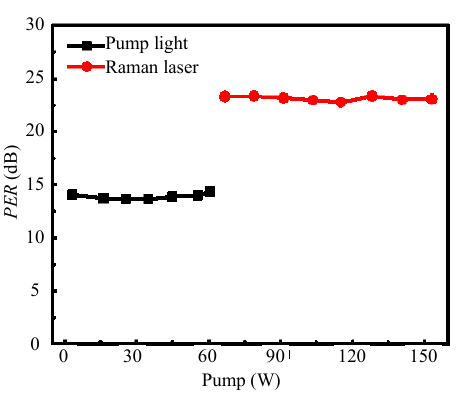
Fig. 4 PER of the pump light and the Raman laser.